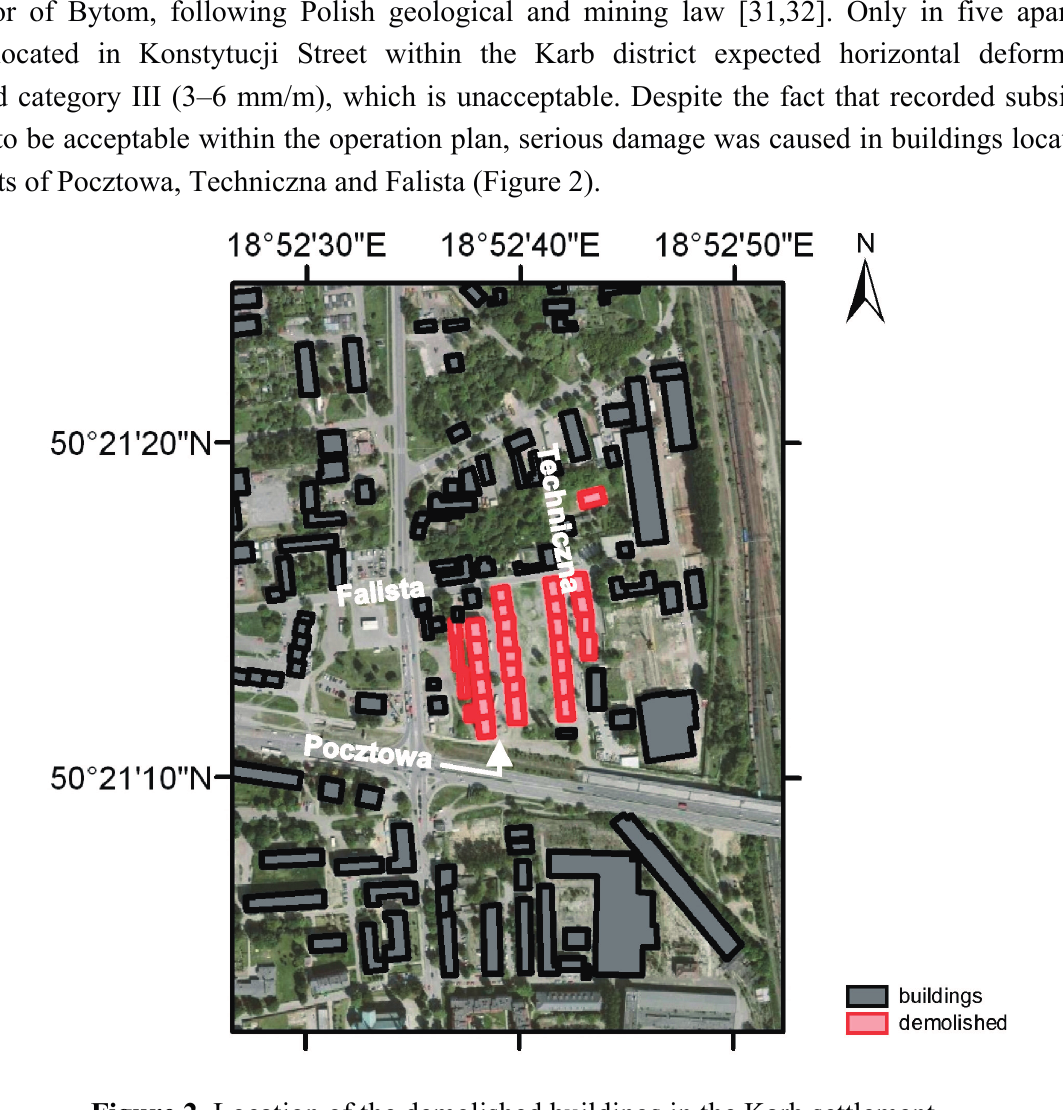
Figure 2. Location of the demolished buildings in the Karb